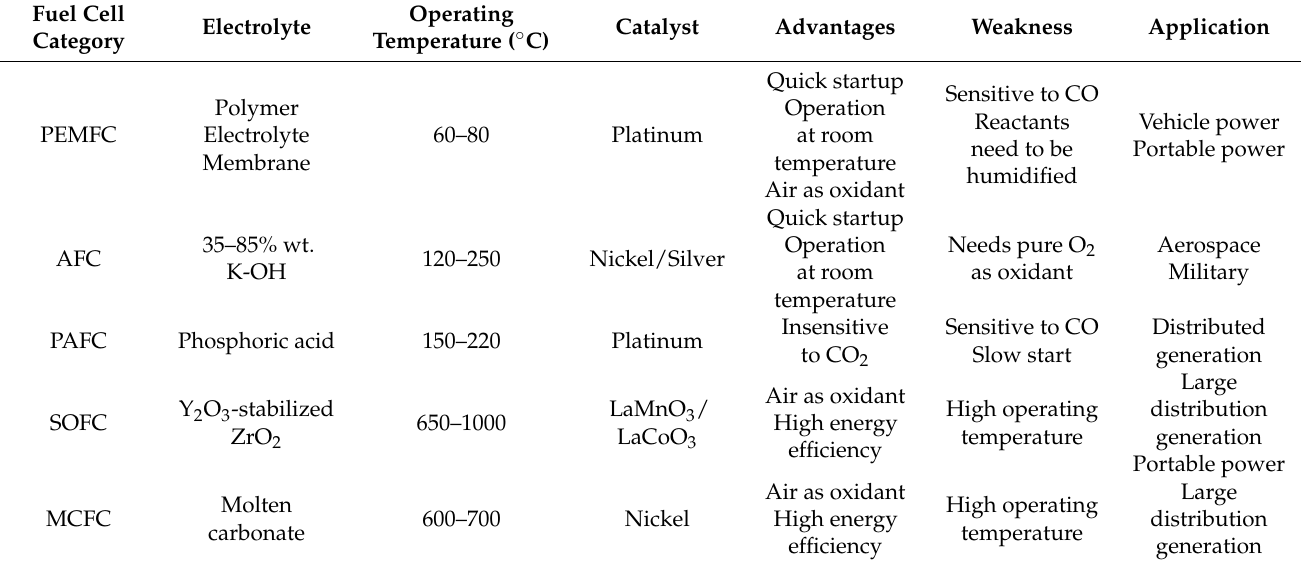
Table 3. Classification of fuel cells based on the type of electrolyte.